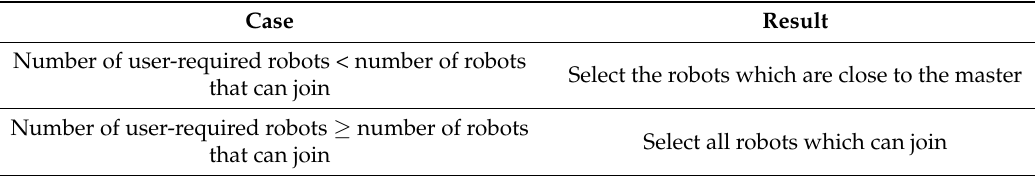
Table 2. Criterion for deciding which robots will join a master.